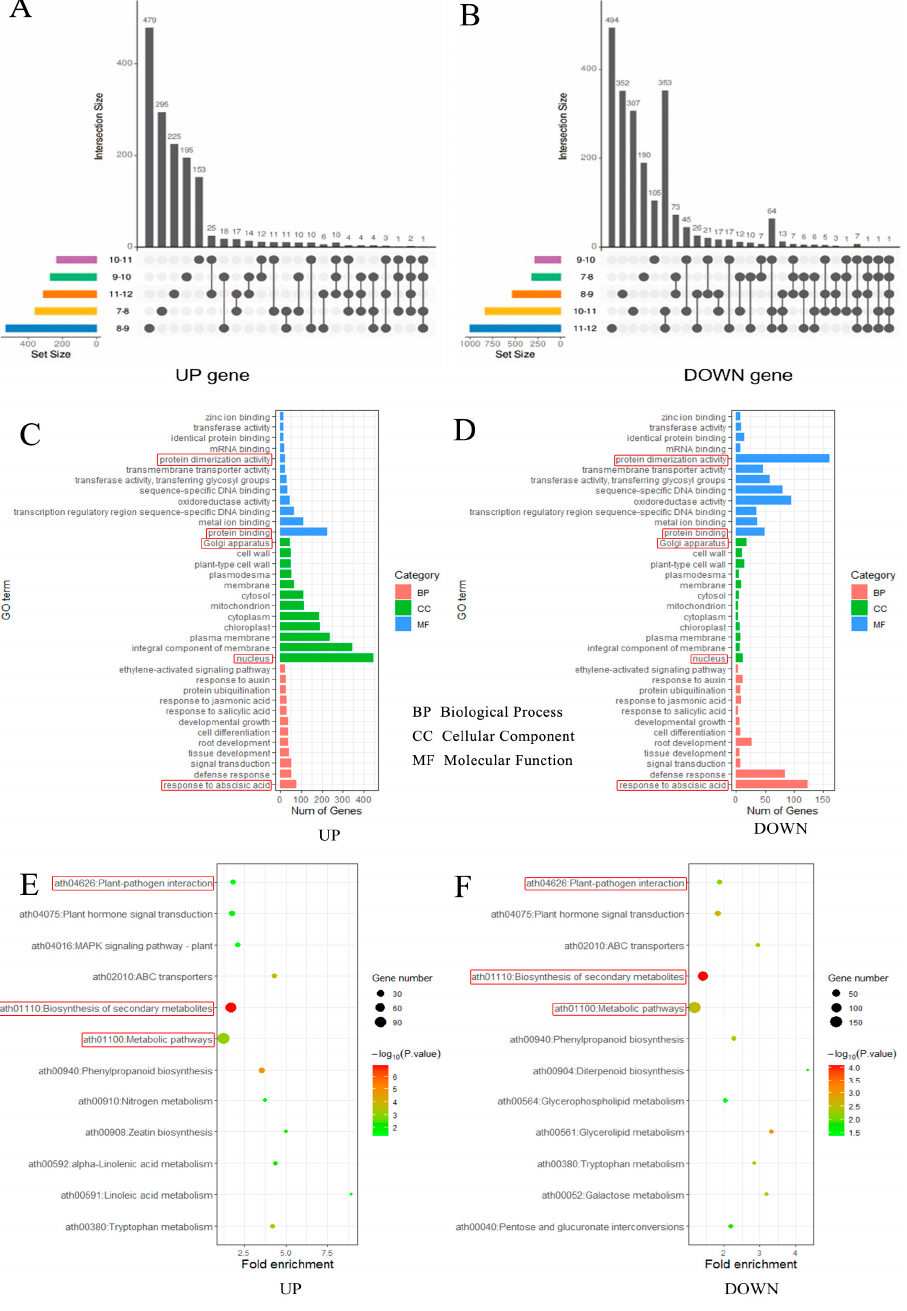
Figure 6. The number, GO annotation, and KEGG enrichment of differentially expressed genes were identified in glyphosate-treated and control groups. ( A , B ) The number of differentially expressed genes in the anthers of different lengths of buds; ( C , D ) GO annotation of the differentially expressed genes; ( E , F ) KEGG enrichment of the differentially expressed